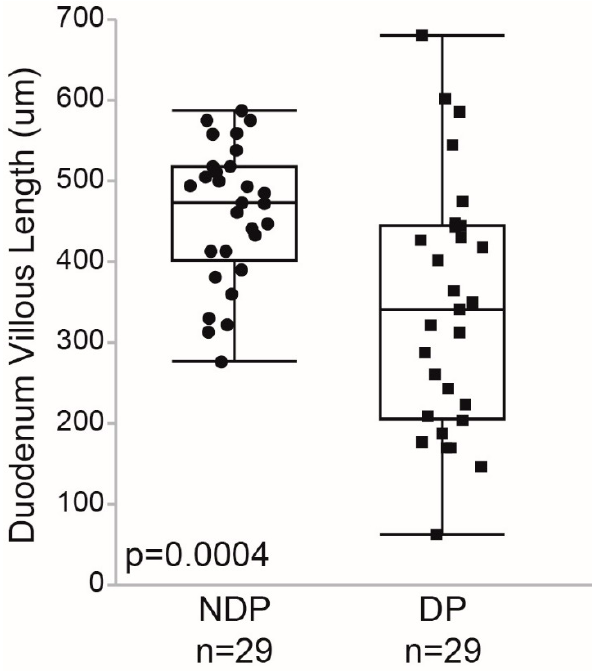
Figure 1. Duodenal villous length for children with Crohn’s disease with duodenal pathology (DP) vs. without duodenal pathology (NDP) at diagnosis.